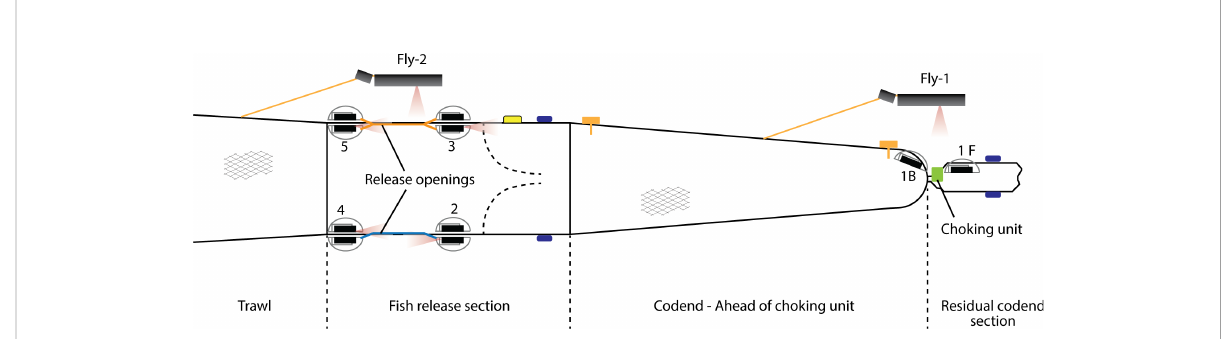
FIGURE 7 Camera positions on the Catch control system and codend. Post-script F means the camera was forward facing (toward the mouth of the trawl) and post-script B means the camera was backwards facing (towards the codend). The red shaded triangles provide an approximate indication of the illuminating light fi eld in some example positions. See Figures 1-3 for further explanation of the fi shing gear